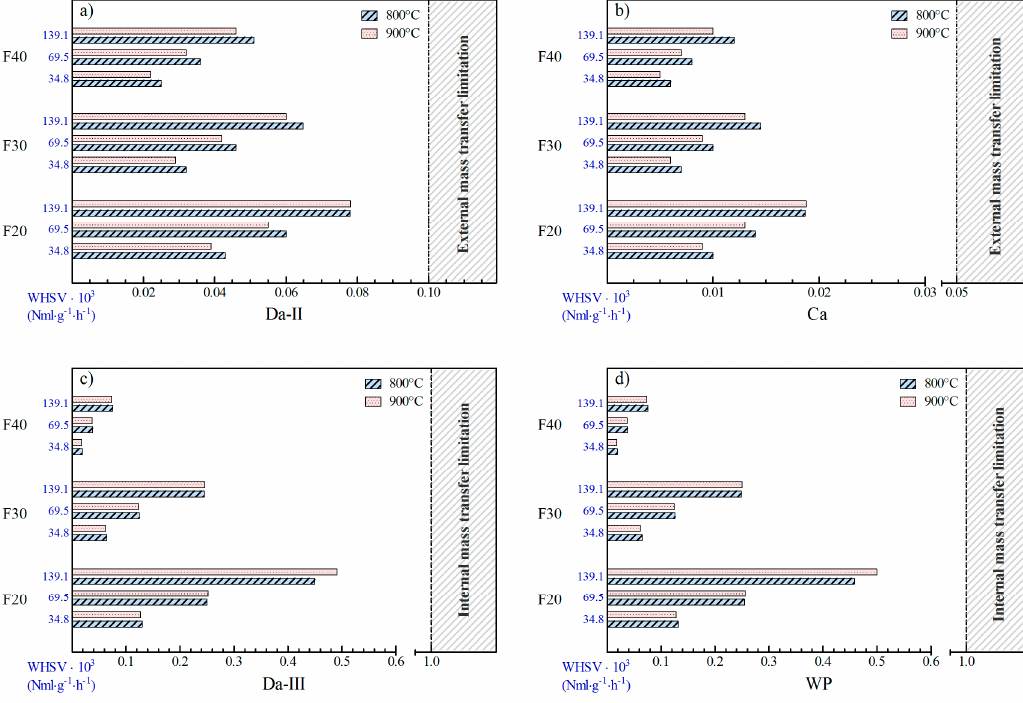
9. Figure 9. Influence of temperature and space velocity on ( a ) Da-II , ( b ) Ca , ( c ) Da-III and ( d ) WP dimensionless numbers on biogas OSR experiments over F20, F30 and F40